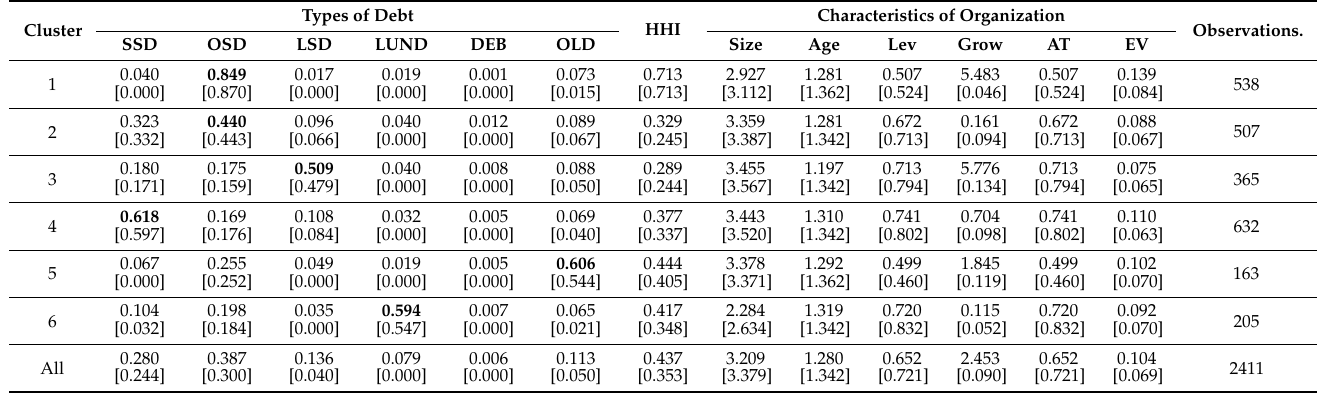
Table 4. Debt specialization cluster analysis.